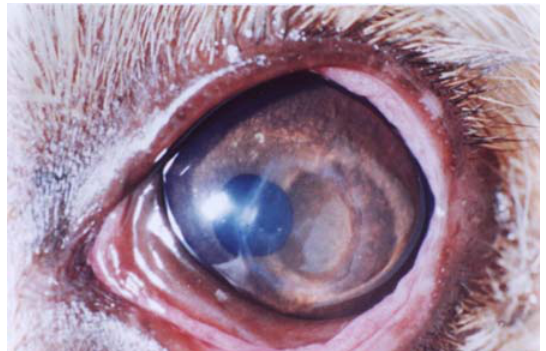
Figure 3. Detail of the keratectomized area 96h after application of the fibrin adhesive derived from snake venom in an animal of Group 3. Detachment of the fibrin adhesive had already occurred; however, fixation of the fluorescein in the keratectomized area is not observed, suggesting there was complete epithelization. Clearness in the central region of the lesion is noticed, indicating that healing occurred without formation of edema in the wound. There is also a slight area of opacity in the periphery of the lesion, representing the initial formation of a scar to perfectly repair the corneal